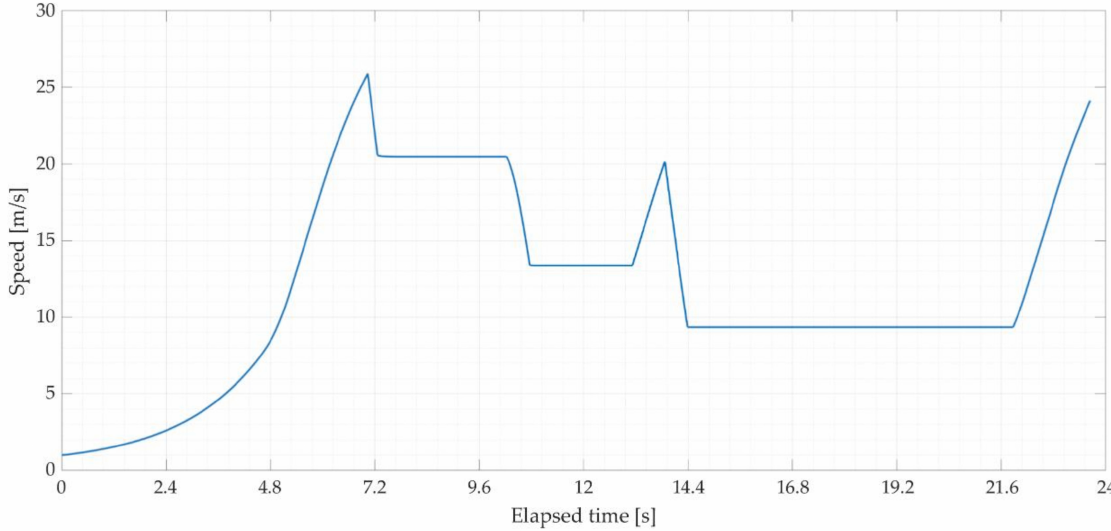
Figure 6. Speed versus lap